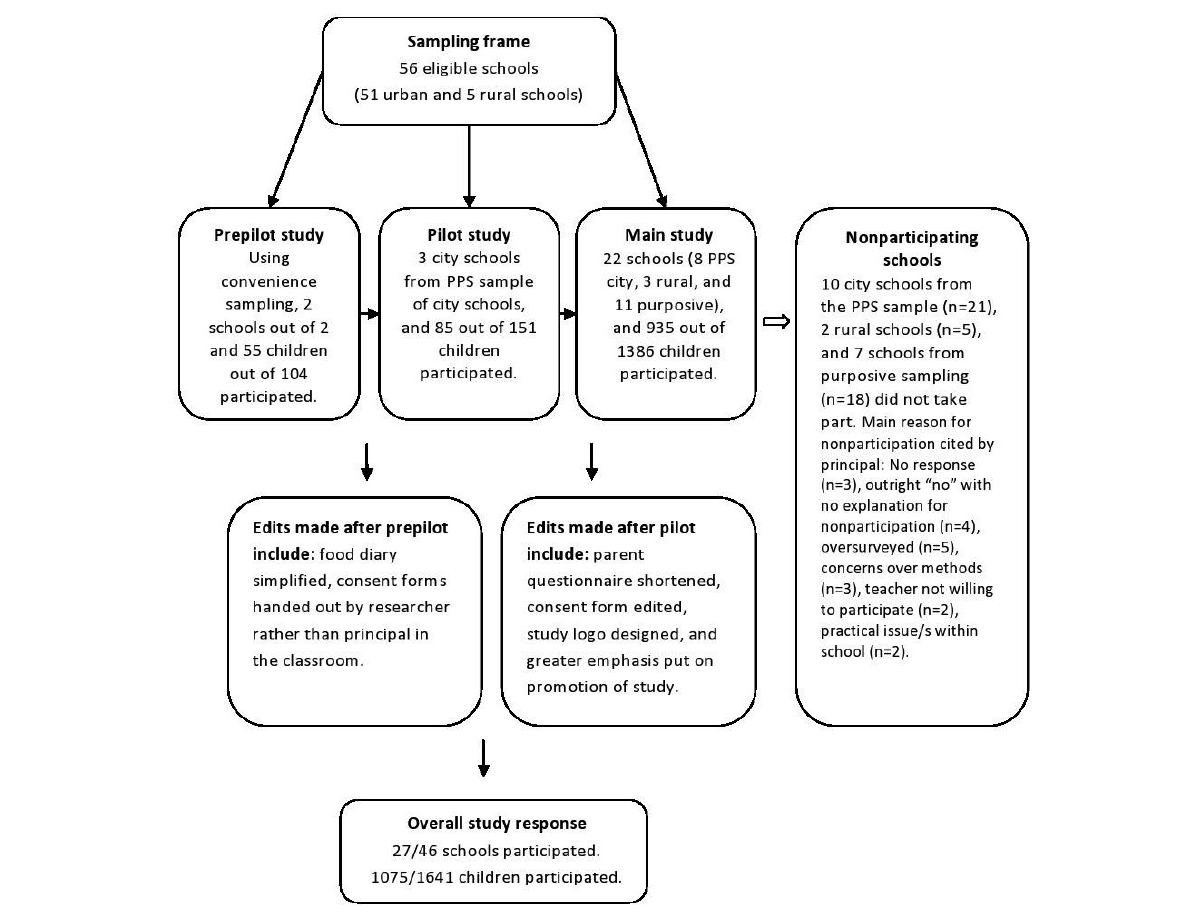
Figure 1. Flowchart of sampling and recruitment of schools and children in the Cork Children’s Lifestyle Study. PPS=probability proportionate to